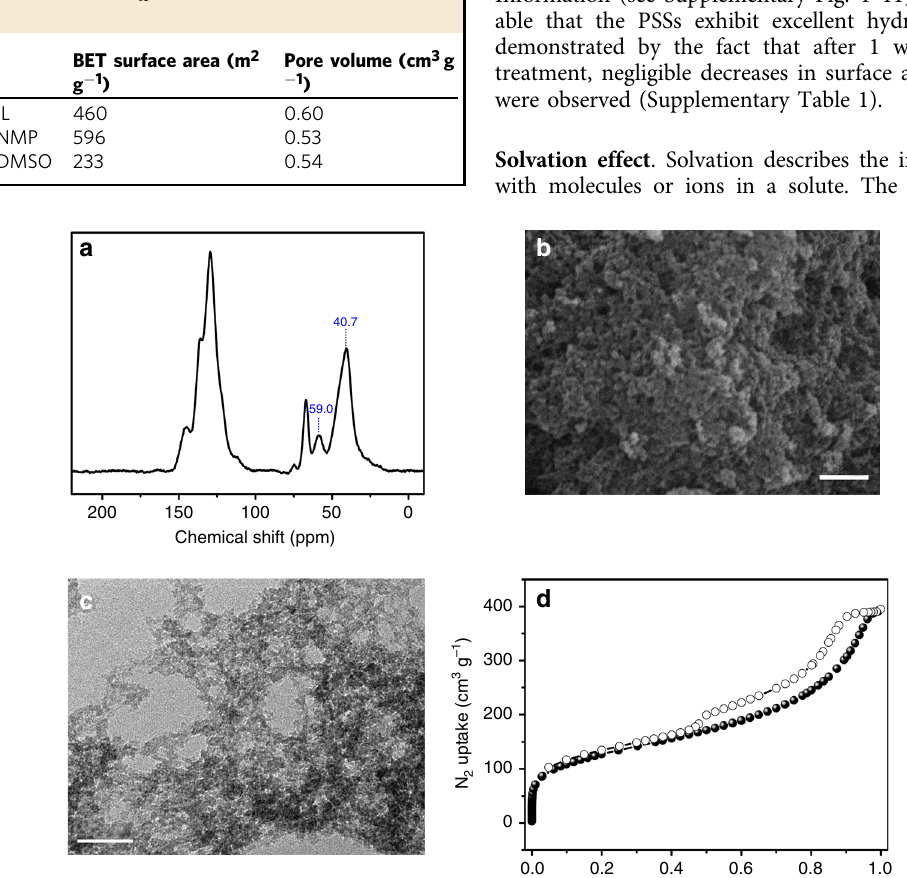
Fig. 2 Characterizations of PSS-IL. a 13 C MAS NMR spectrum, b SEM image (scale bar denotes 500 nm), c TEM image (scale bar denotes 100 nm), and d N 2 sorption isotherms collected at − 196 °C of PSS-IL